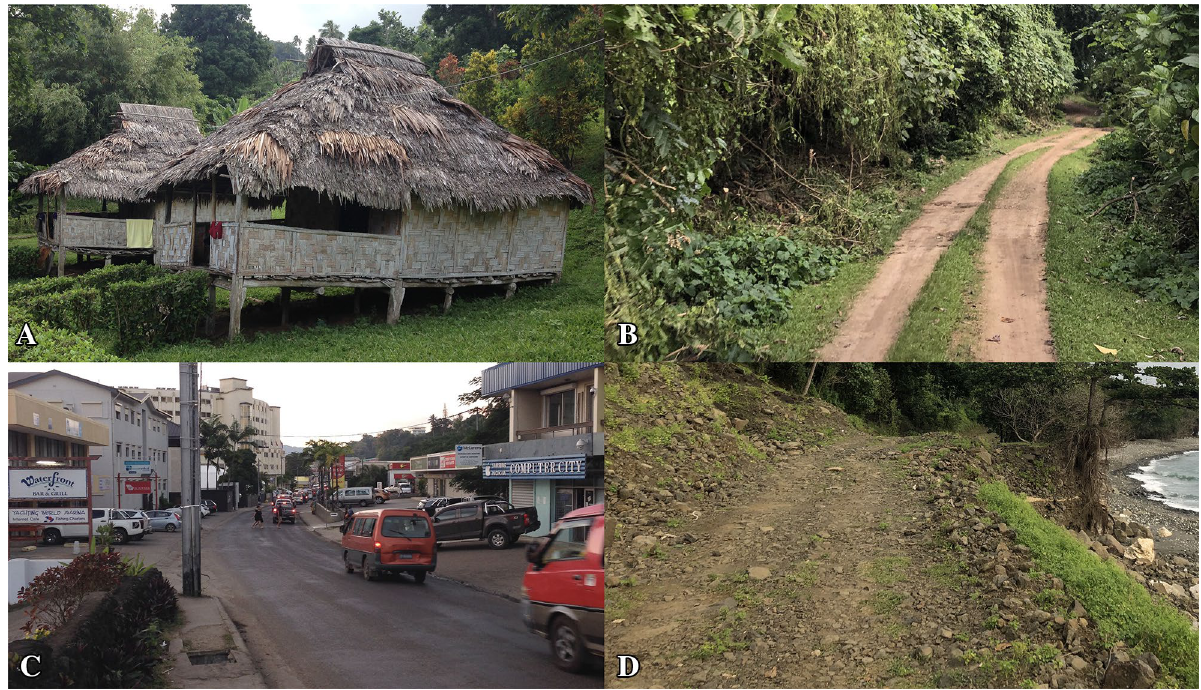
Figure 8. ( A ) Example of settlements on more remote islands. ( C ) Example of settlements and roads on more developed islands. ( B – D ) Variation within roads across the islands (Photo credit: Colin Jensen and Natalie